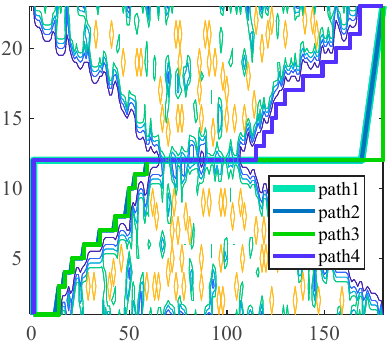
Figure 27. Binary map of case 2.